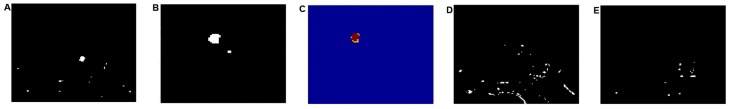
Illustration of focal lobular neoplasia (case III).(A)-(E) Segmented tumours using FCMs and the proposed hybrid classification, overlapping images, and depiction of noisy voxels from imaged fatty tissue, using both classification methods; the fewer noisy voxels in E relate to results from the proposed algorithm.